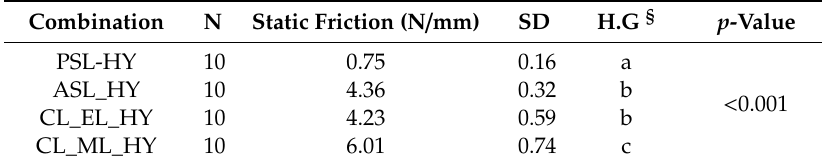
Table 6. Static friction values using hybrid section stainless steel wire (HY). The letters show significance statistical differences.